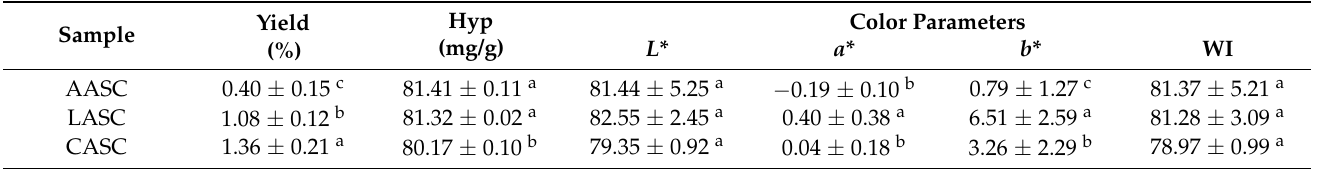
Table 1. Yield, Hyp composition, and color parameters of the acid soluble unicornfish (N. reticulatus) bone